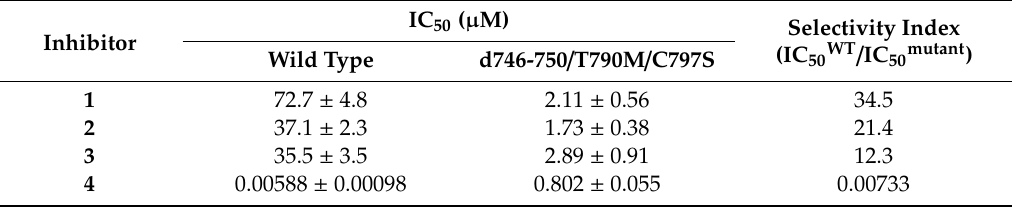
Figure 3. Chemical structures of the four inhibitors of the d746-750 / T790M / C797S mutant EGFR identified from virtual and biochemical screening. Table 1. IC 50 values of the four inhibitors of the d746-750 / T790M / C797S mutant EGFR in comparison with those for the wild type. Selectivity index is also given by the ratio of IC 50 for the wild type to that for the triple mutant.